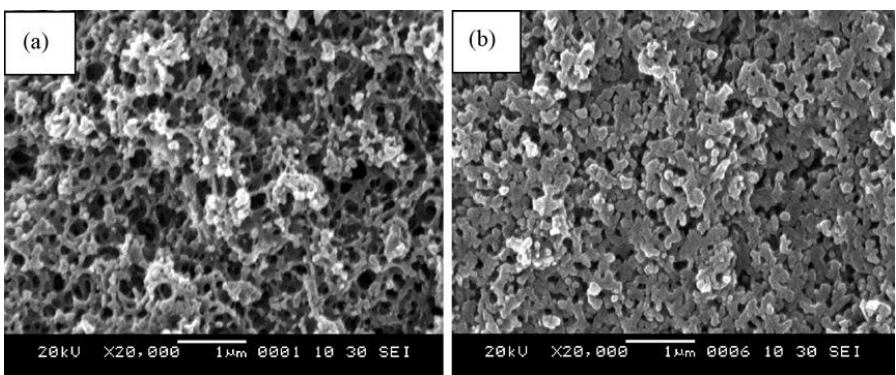
Figure 29. SEM electron photomicrographs of organic aerogel ( a ) and the carbon aerogel derived from it ( b ) (reproduced from the work in [89] with permission). Cyclic voltammograms (CV) deviate from the rectangular shape at higher scan rates as higher scan rates lessen the amount of time ions must be transported into the pores, shown in Figure 30.